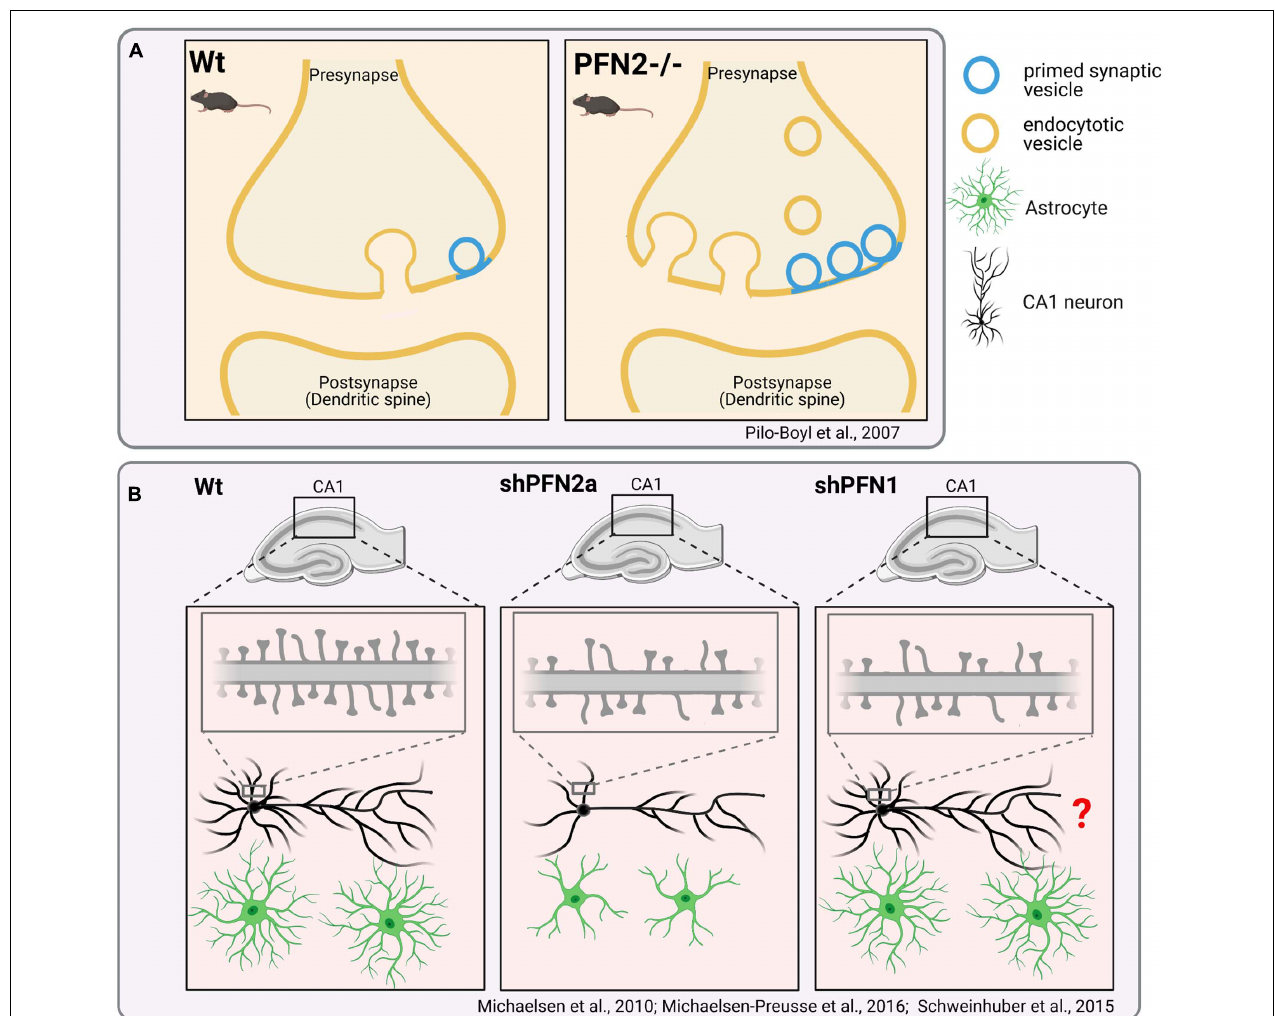
FIGURE 5 | Distinct effects of PFN1- or PFN2- “loss-of-function” in neuronal cells. (A) Genetic ablation of Profilin2 and impact on synapses: Presynapses in pfn2 -deficient mice show an increased number of primed synaptic vesicles. Increased exocytosis of synaptic vesicles cause hyperactivity and changed complex behaviors in pfn2 -/- mice, such as increased novelty-seeking (Pilo Boyl et al., 2007). Further studies also indicate increased endocytosis in pfn2 -/-mice (Gareus et al., 2006; Luscieti et al., 2017). Pfn2 − / − animals display no gross changes in brain anatomy. (B) shRNA-mediated acute depletion of PFN2a in organotypic slice cultures reduces dendritic complexity and spine densities of hippocampal CA1 neurons (Michaelsen et al., 2010). shPFN1 treatment of neurons reduces the overall densities of mature dendritic spines (Michaelsen-Preusse et al., 2016). It was not described, if PFN1 knockdown also affects the dendritic arborization of CA1 neurons (labeled with “?”). Rescue experiments indicate that PFN1 is unable to compensate PFN2a-specific defects in dendritic complexity. Depletion of PFN2a but not PFN1 affects the overall volume of astrocytes in organotypic slice cultures (Schweinhuber et al.,